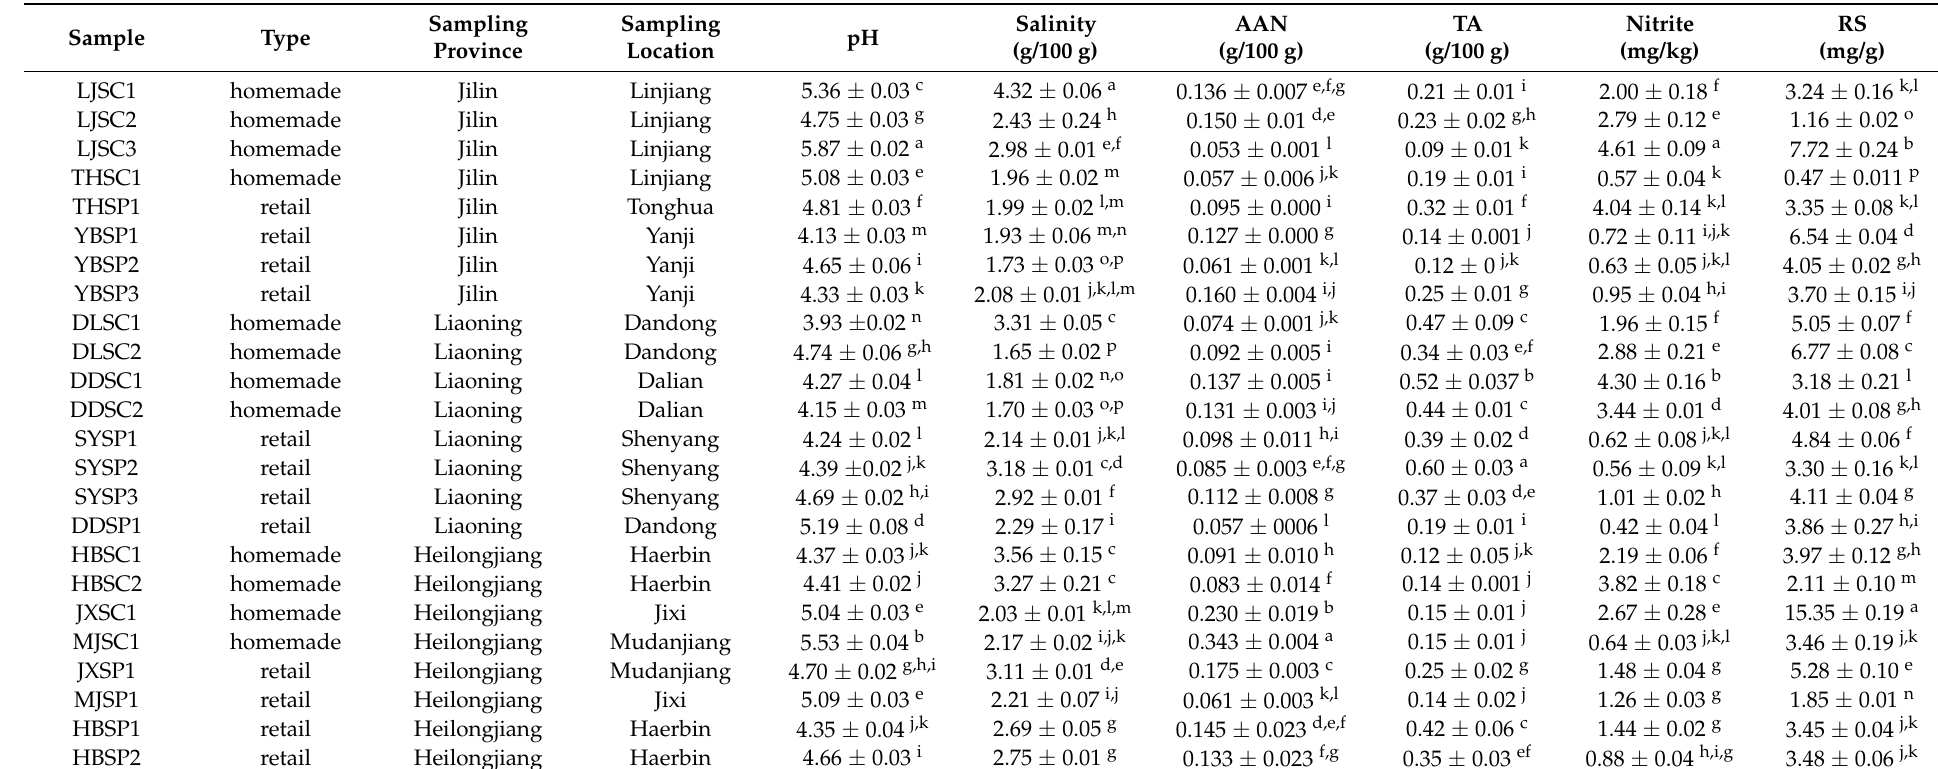
Table 1. Physicochemical properties of the CSC